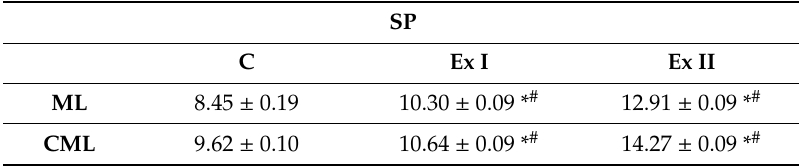
Table 3. The distribution of intramural nerve fibers containing selected neuronal active substances in the porcine